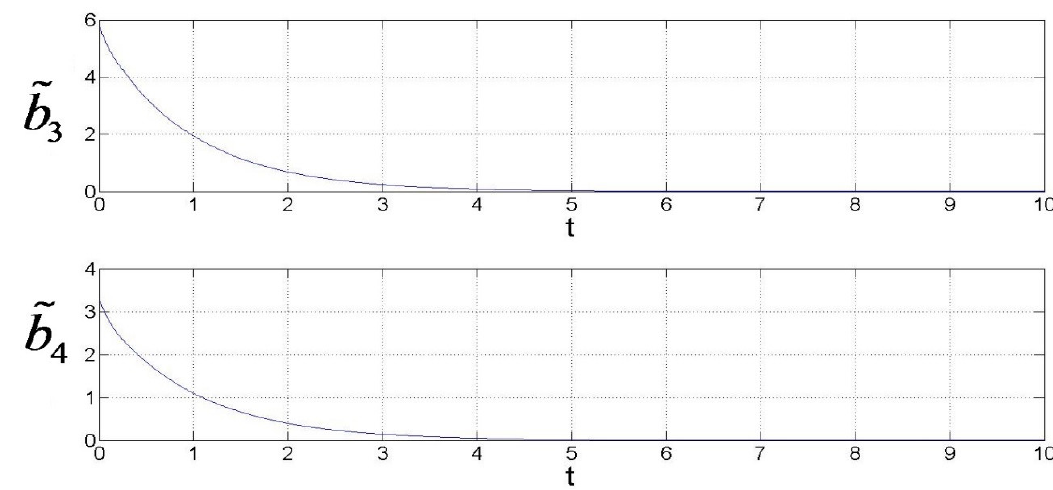
Figure 5. Time series for the error states.